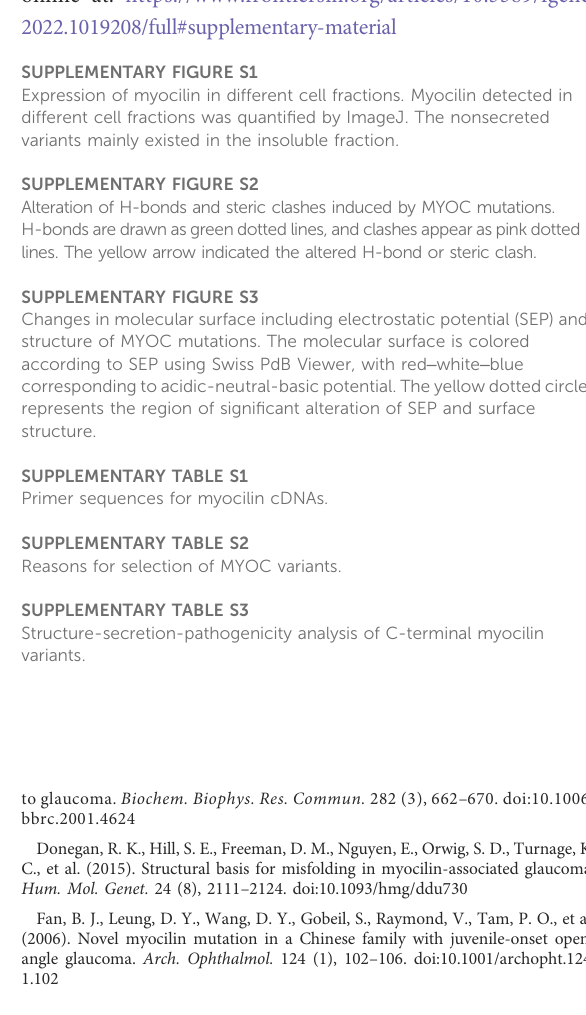
SUPPLEMENTARY FIGURE S1 Expression of myocilin in different cell fractions. Myocilin detected in different cell fractions was quanti fi ed by ImageJ. The nonsecreted variants mainly existed in the insoluble fraction. SUPPLEMENTARY FIGURE S2 Alteration of H-bonds and steric clashes induced by MYOC mutations. H-bondsaredrawnasgreendottedlines,andclashesappearaspinkdotted lines. The yellow arrow indicated the altered H-bond or steric clash. SUPPLEMENTARY FIGURE S3 Changes in molecular surface including electrostatic potential (SEP) and structure of MYOC mutations. The molecular surface is colored according to SEP using Swiss PdB Viewer, with red ‒ white ‒ blue corresponding to acidic-neutral-basic potential.The yellow dottedcircle represents the region of signi fi cant alteration of SEP and surface structure. SUPPLEMENTARY TABLE S1 Primer sequences for myocilin cDNAs. SUPPLEMENTARY TABLE S2 Reasons for selection of MYOC